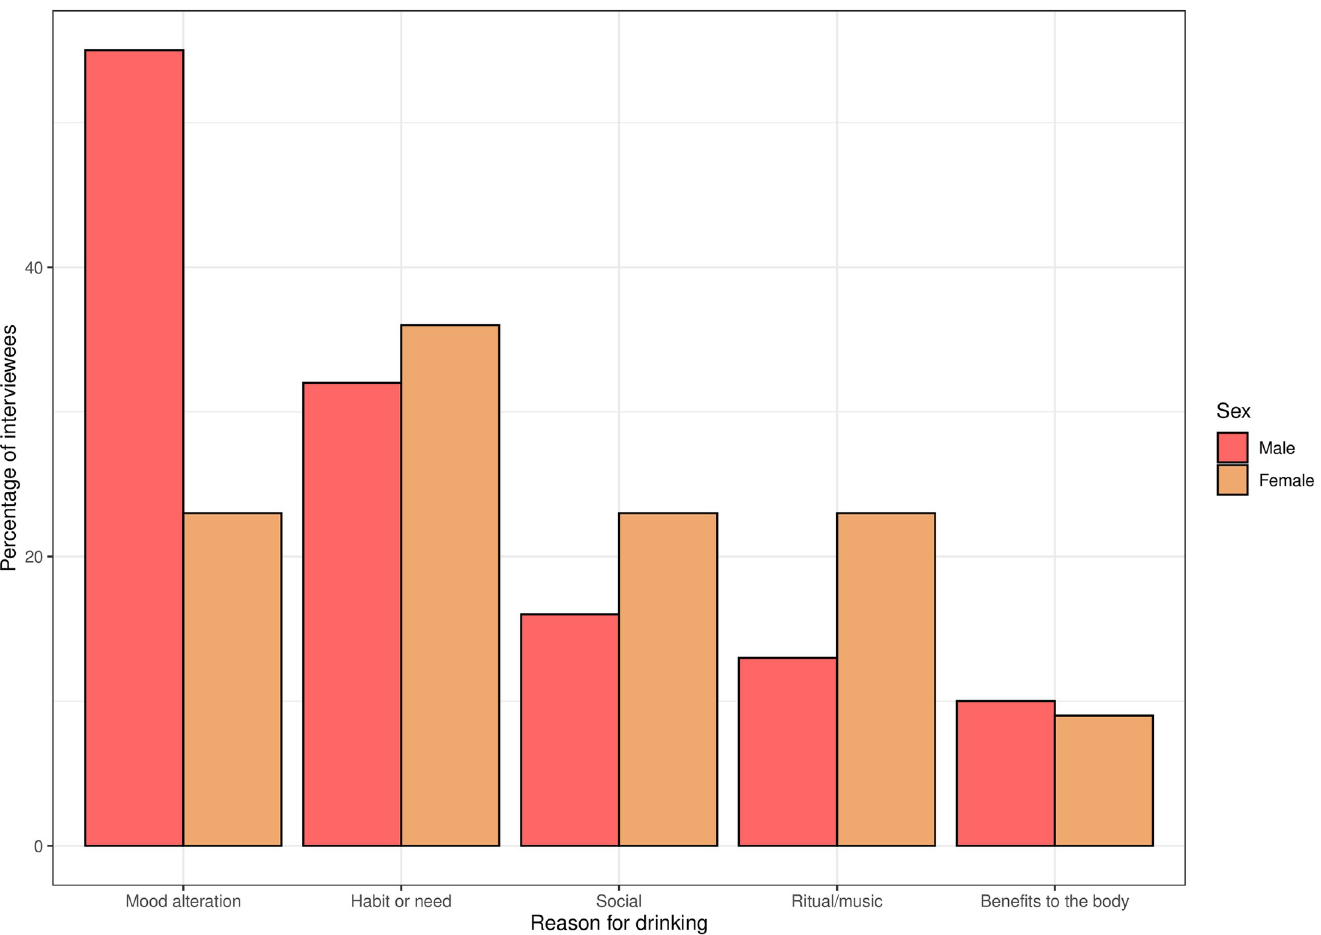
Fig 4. Bar chart of participants’ stated reasons for drinking, separated by